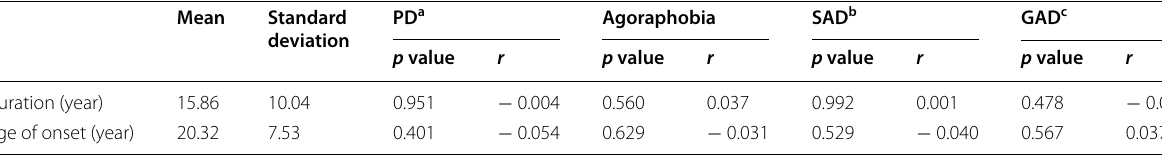
a Panic disorder b Social anxiety disorder c Generalized anxiety